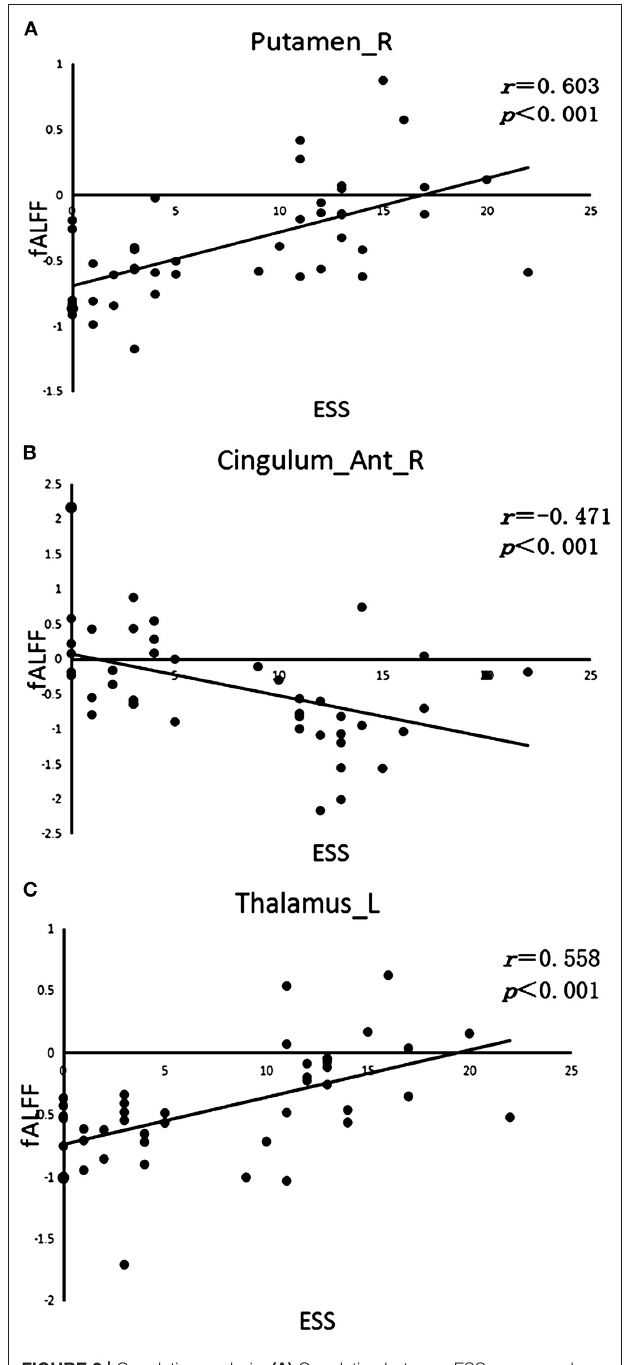
FIGURE 2 | Correlation analysis. (A) Correlation between ESS scores and fALFF value in the right putamen (Putamen-R). (B) Correlation between ESS scores and fALFF value in the right anterior cingulate gyrus (Cingulum-Ant-R). (C) Correlation between ESS scores and fALFF value in the left thalamus